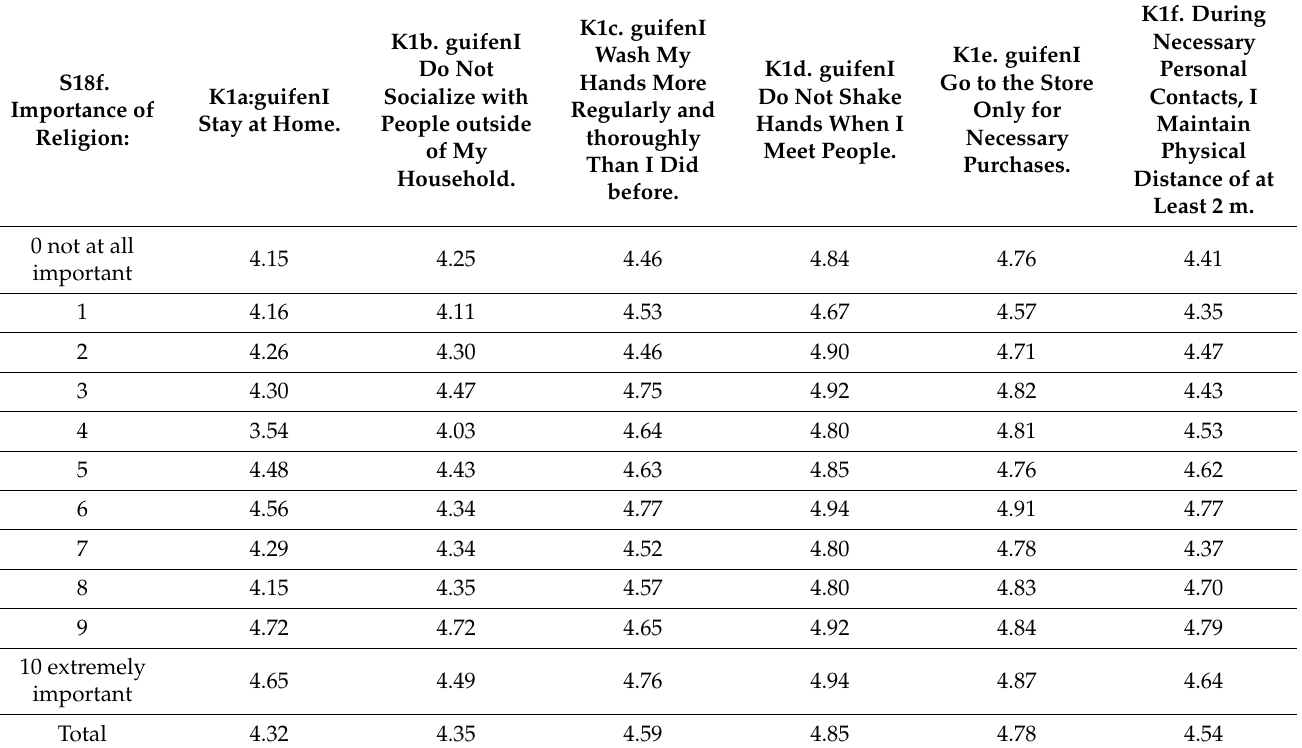
Table 2. The importance of religion and adherence to rules and